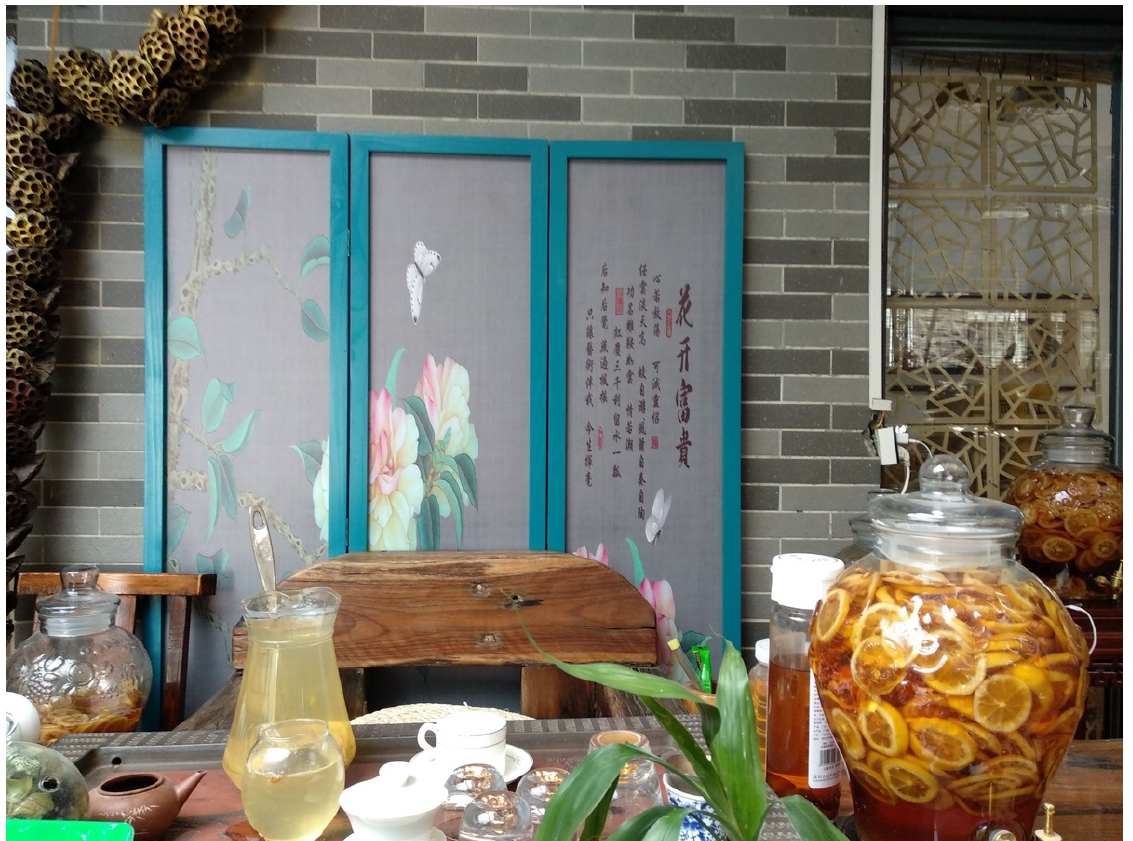
Figure 4 Ms. Li’s fermented lemons